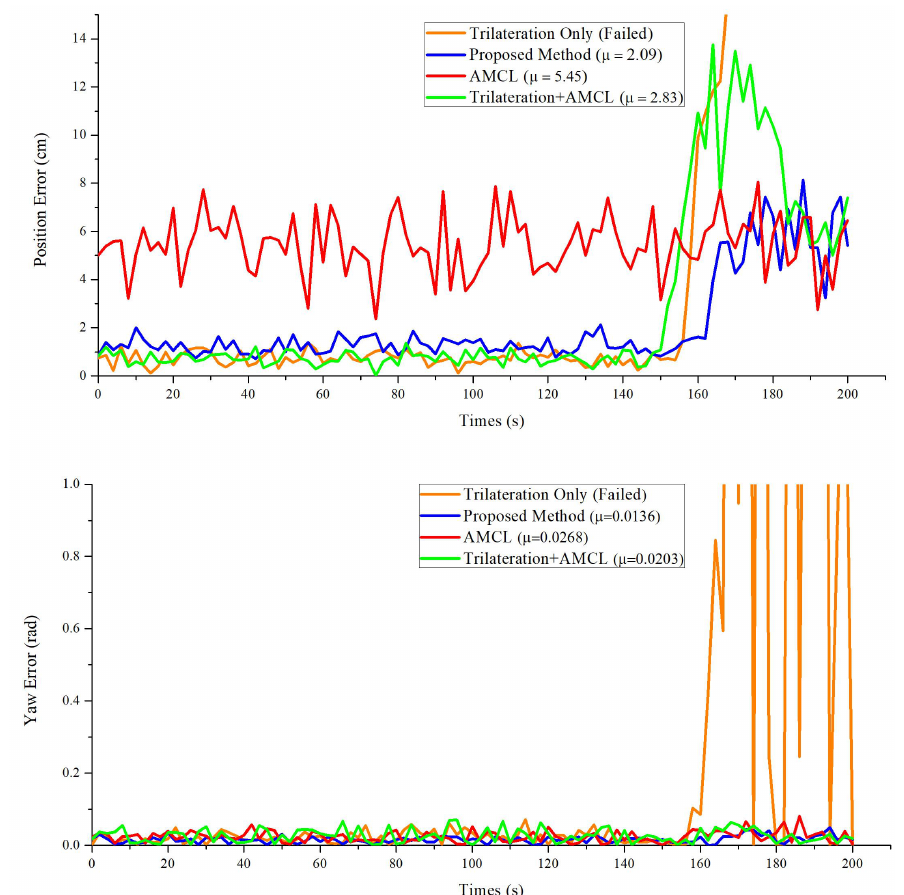
Figure 10. Comparison results of our proposed method with trilateration-only method, AMCL and T-AMCL. ( a ) Position Error vs. Time, ( b ) Yaw Error vs.